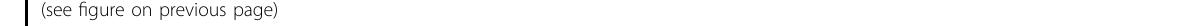
Fig. 4 PXDN reduces autophagic fl ux via FoxO1 inhibition. A H9C2 cells were treated with 50 μ M si-negative control (NC), si-PXDN, si-FoxO1, or si-PXDN plus si-FoxO1 in serum-free medium for 24 h, and treated with 400 μ M palmitate acid (PA) for another 24 h. Cell survival was evaluated using fl uorescence staining with calcein acetoxymethyl ester (Calcein-AM) for live cells in green and ethidium homodimer-1 (EthD-1) for dead cells in red. The percentage of cell death was shown on the right side (scale bar = 50 μ M, n = 4). B AC16 cells were treated with NC, si-PXDN, si-FoxO1, or si- PXDN plus si-FoxO1 in serum-free medium for 24 h, and treated with 400 μ M PA for another 24 h. Cell survival was evaluated using fl uorescence staining. The percentage of cell death was shown on the right side (scale bar = 50 μ M, n = 4). C Autophagosomes and autolysosomes in PA-treated H9C2 with si-NC, si-PXDN, si-FoxO1, or si-PXDN plus si-FoxO1 were detected by transmission electron microscopy. Black Arrow referred to autophagosomes and white arrow referred to autolysosomes. The number of autophagosomes and autolysosomes per cell was shown on the right side (scale bar = 20 μ m in top and 6 μ m in bottom, respectively. n = 3). D H9C2 cells were treated with 50 μ M si-NC, si-PXDN, si-FoxO1, or si-PXDN plus si-FoxO1 in serum-free medium for 24 h, and treated with 400 μ M PA with or without 1 μ M DC661 for another 24 h. PXDN, FoxO1, LC3II, and p62 levels were detected by western blot. Quantitative analyses were shown below ( n = 4 – 8). E Western blot of PXDN 、 p-FoxO1, and FoxO1 in PA- treated H9C2 with si-NC, si-PXDN, si-FoxO1, or si-PXDN plus si-FoxO1 ( n = 4). Quantitative analyses were shown below ( n = 4). Data were presented as mean ± SEM. One-way ANOVA test was used. * P < 0.05, ** P < 0.01, *** P <